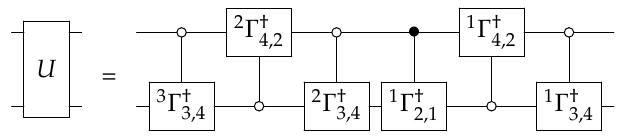
Figure 8. Decomposition into the Givens rotations